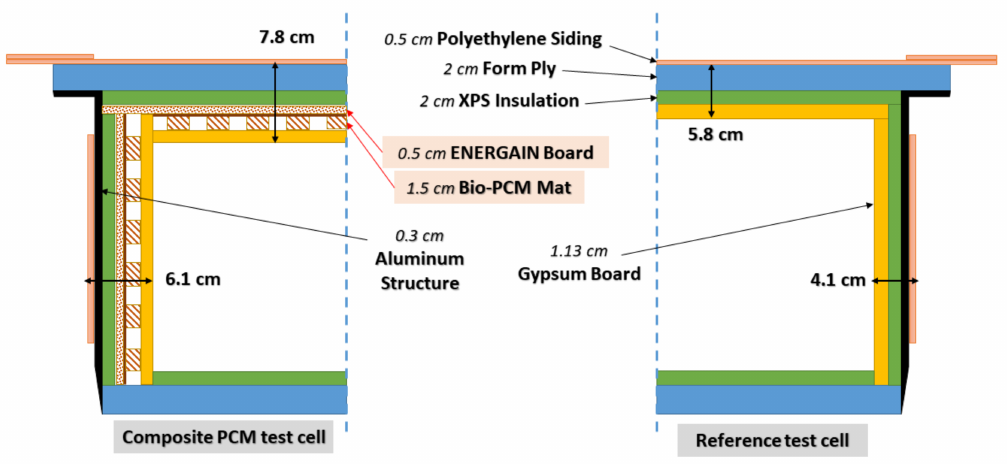
Figure 8. Cross-section of composite PCM test facility and reference facility